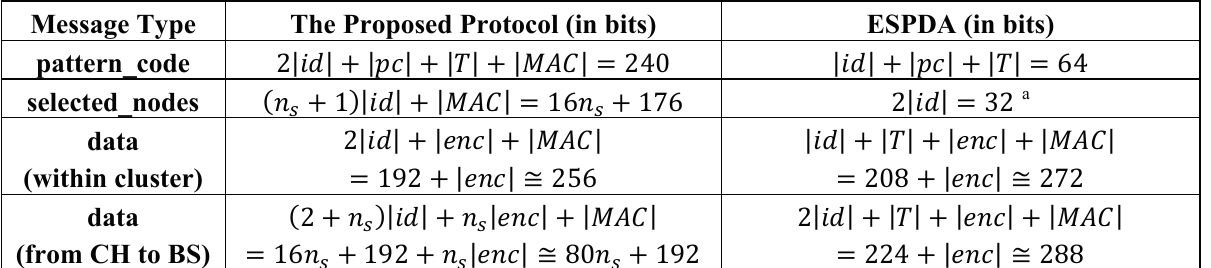
Table 7. Message size comparison for data aggregation phase.